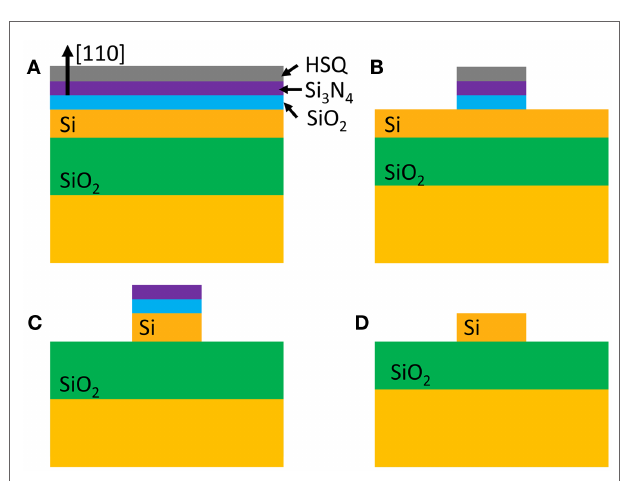
FigUre 2 | anisotropic wet etching process: (a) a [110]-sOi substrate is covered with thin layers of siO 2 , si 3 n 4 , and hsQ . (B) Desired patterns are written in HSQ layer using e-beam lithography and then transferred to the hard mask (SiO 2 and Si 3 N 4 ) using dry and wet etching processes. (c) The patterns were transferred to the SOI using TMAH solution. (D) Finally, the hard mask was removed using a combination of dry and wet etching processes.